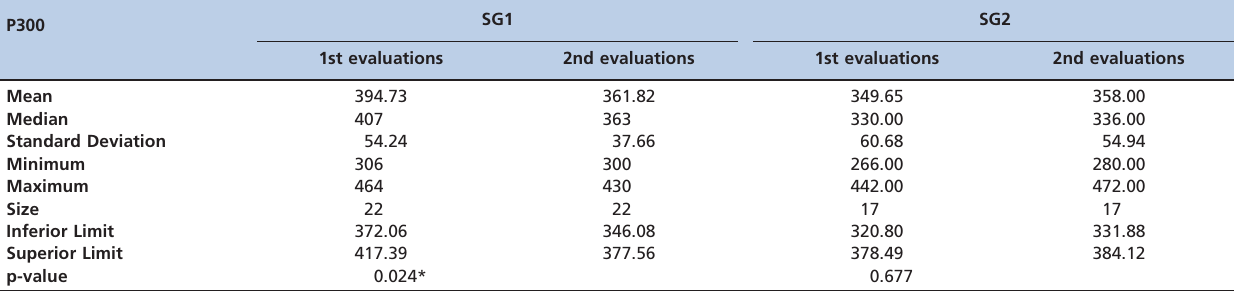
Table 6 - The comparisons between the first and second evaluations regarding the P300 latencies for subgroups SG1 and